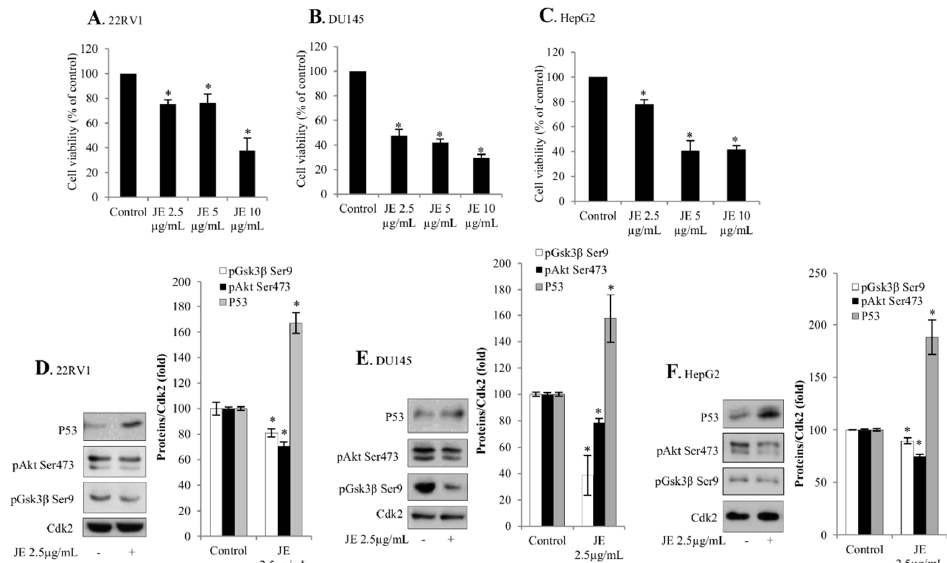
Figure 3. JE decreased both pAkt levels and cell proliferation in prostate and liver cancer cells. Serum-starved 22RV1, DU145, and HepG2 cells were treated with JE for 24 h. ( A – C ) Cell proliferation was estimated by MTT assay. ( D – F ) Cell lysates were analyzed for pAkt Ser473, pGsk3 β Ser9, and P53 by Western blotting. Cdk2 was used as loading control. Data are presented as bars ± standard deviation from three independent experiments. * Significantly different from control, p ≤ 0.05.